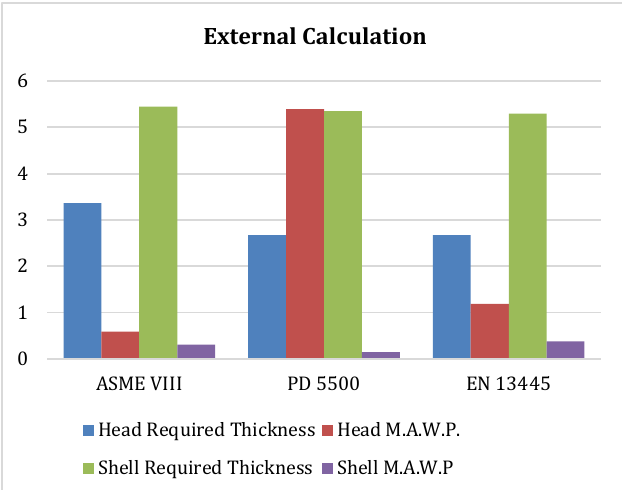
Figure 2: External calculation for head and shell.